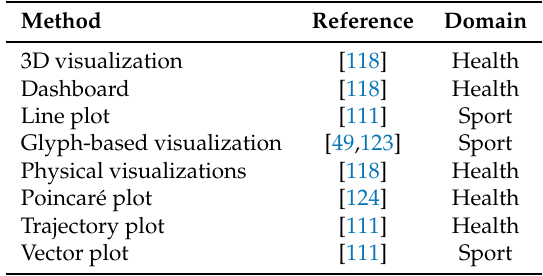
Table 5. Visualization methods that are used for the visualization of measurements produced by wearables.